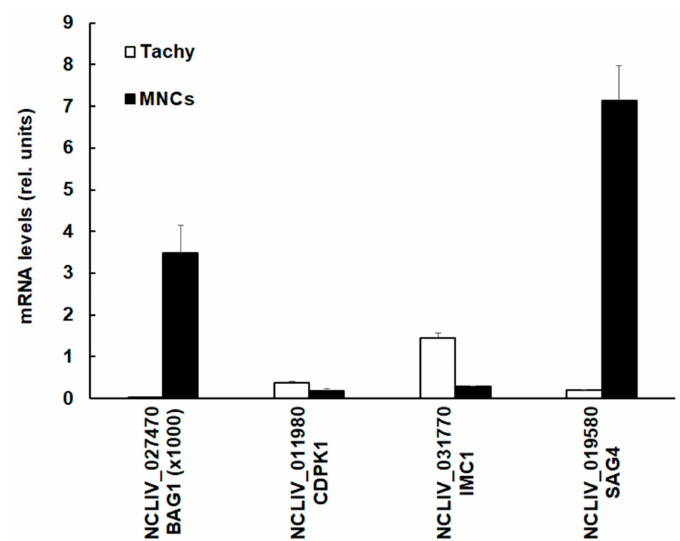
Figure 4. Quantitative assessments of mRNA levels of four selected genes. Confluent human foreskin fibroblast monolayers were infected with N. caninum tachyzoites and left untreated for the generation of tachyzoites (Tachy, white bars) or treated with BKI-1294 in order to generate MNCs (MNCs; black bars). Cells were harvested, mRNA was extracted, cDNA was prepared, and mRNA levels were quantified as described in Section 2.5. Mean ± standard error values from four replicates were assessed and expression levels were given as values in arbitrary units relative to the amount of 28S rRNA. The genes are termed by their respective accession numbers in